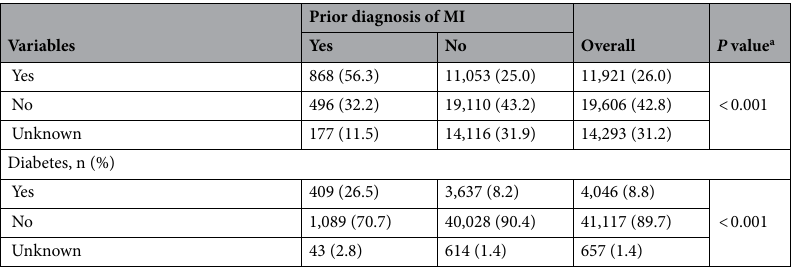
Table 1. Baseline characteristics of 45,820 participants. a Comparison between those with or without a prior diagnosis of MI. b Representing the usual intake of nutrients. d day, IQR Interquartile range, MI Myocardial infarction, MUFA Monounsaturated fatty acid, n number, NA Not applicable, PUFA Polyunsaturated fatty acid, SD Standard deviation, SFA Saturated fatty acid.